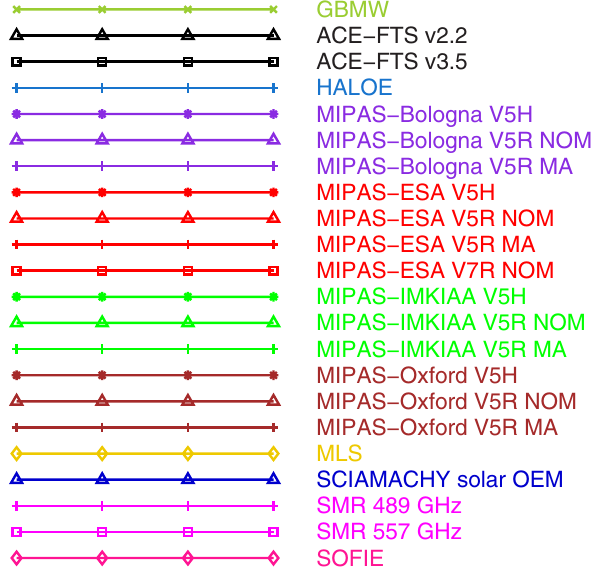
Figure 1. The color and symbol scheme used for instruments and their retrieval versions used in comparisons throughout this